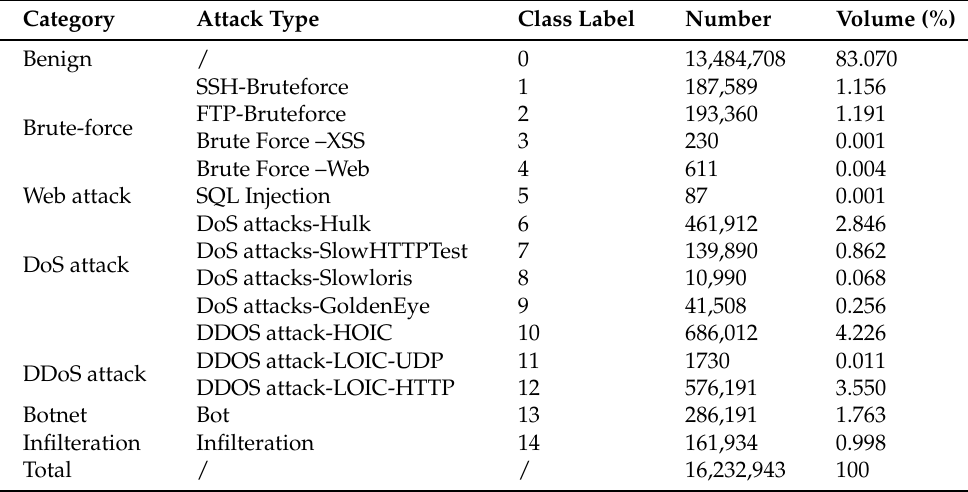
Figure 1. Schematic diagram of the two-stage NIDS model. Table 2. Number of samples in each category of the CSE-CIC-IDS2018